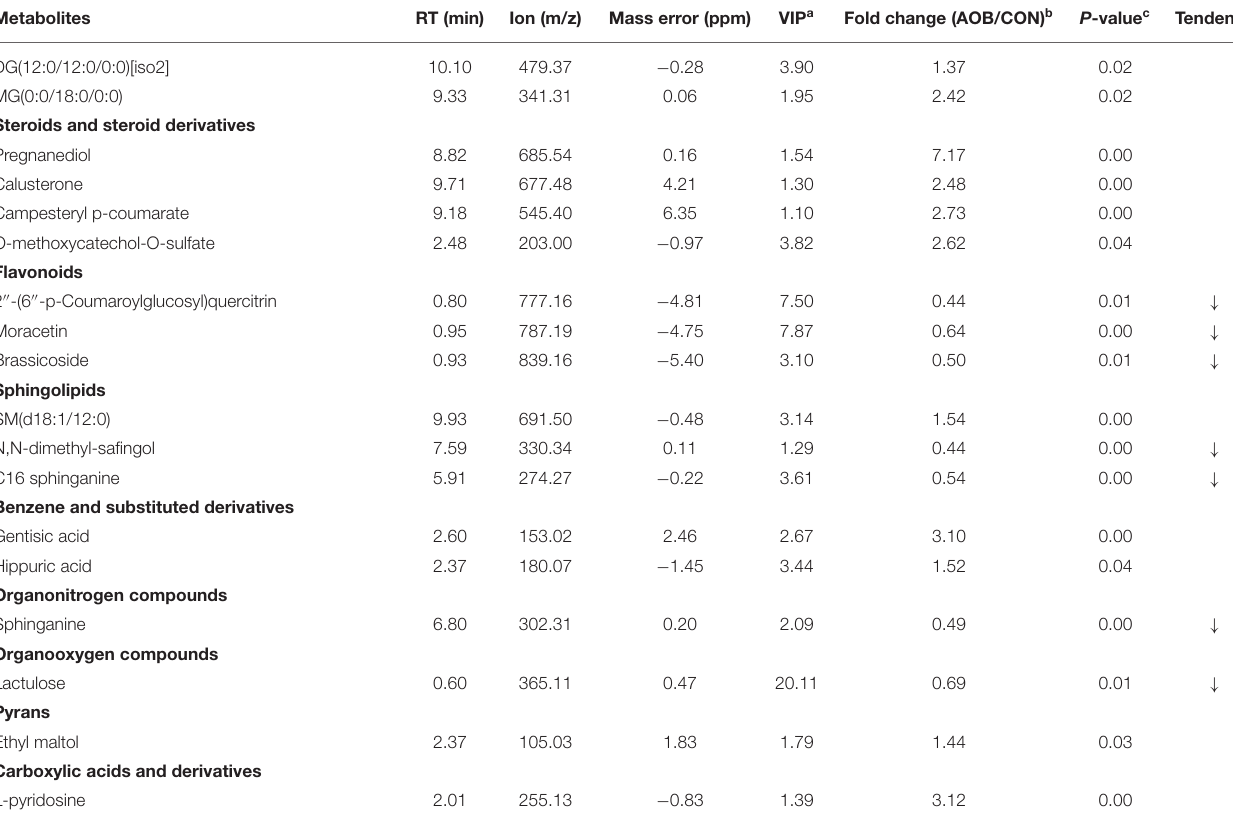
Frontiers in Nutrition |